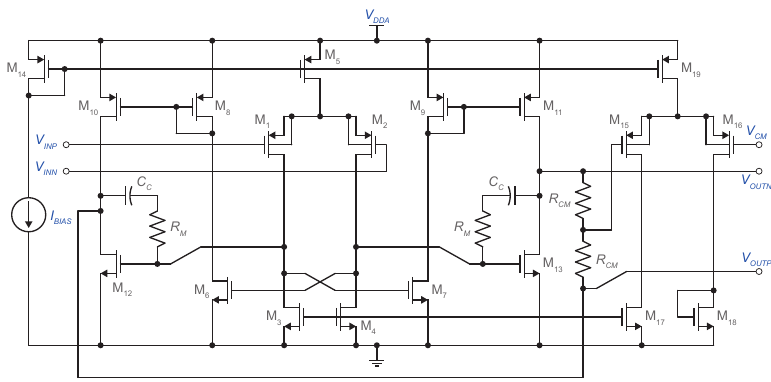
Figure 6. Circuit schematic of the two-stage Class A/AB operational amplifier.